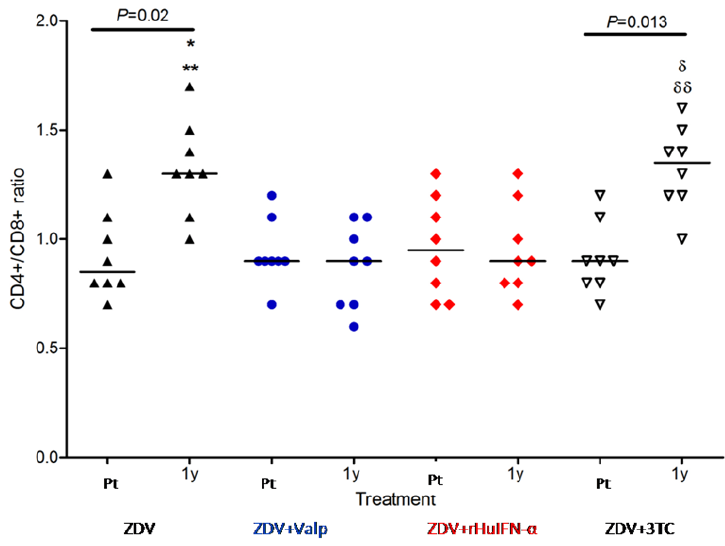
Figure 1. CD4+/CD8+ ratios in cats treated with either Zidovudine (ZDV) alone or in combination with Valproic acid (Valp), Recombinant Human Interferon - α (rHuIFN- α ),